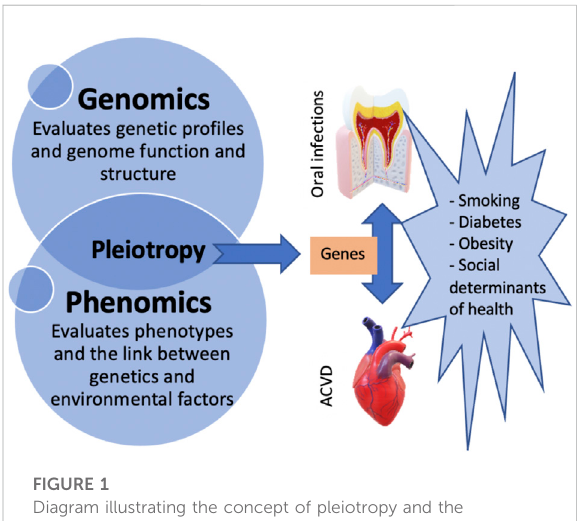
FIGURE 1 Diagram illustrating the concept of pleiotropy and the association between oral infections, ACVD, and their risk